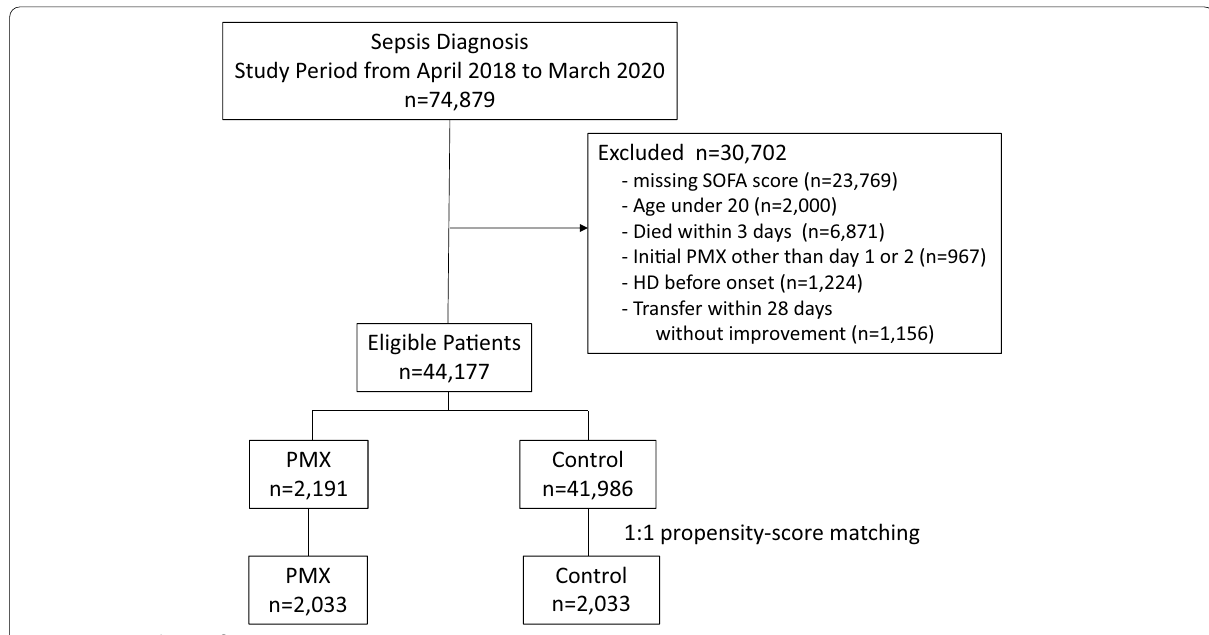
Fig. 1 Patient selection flow